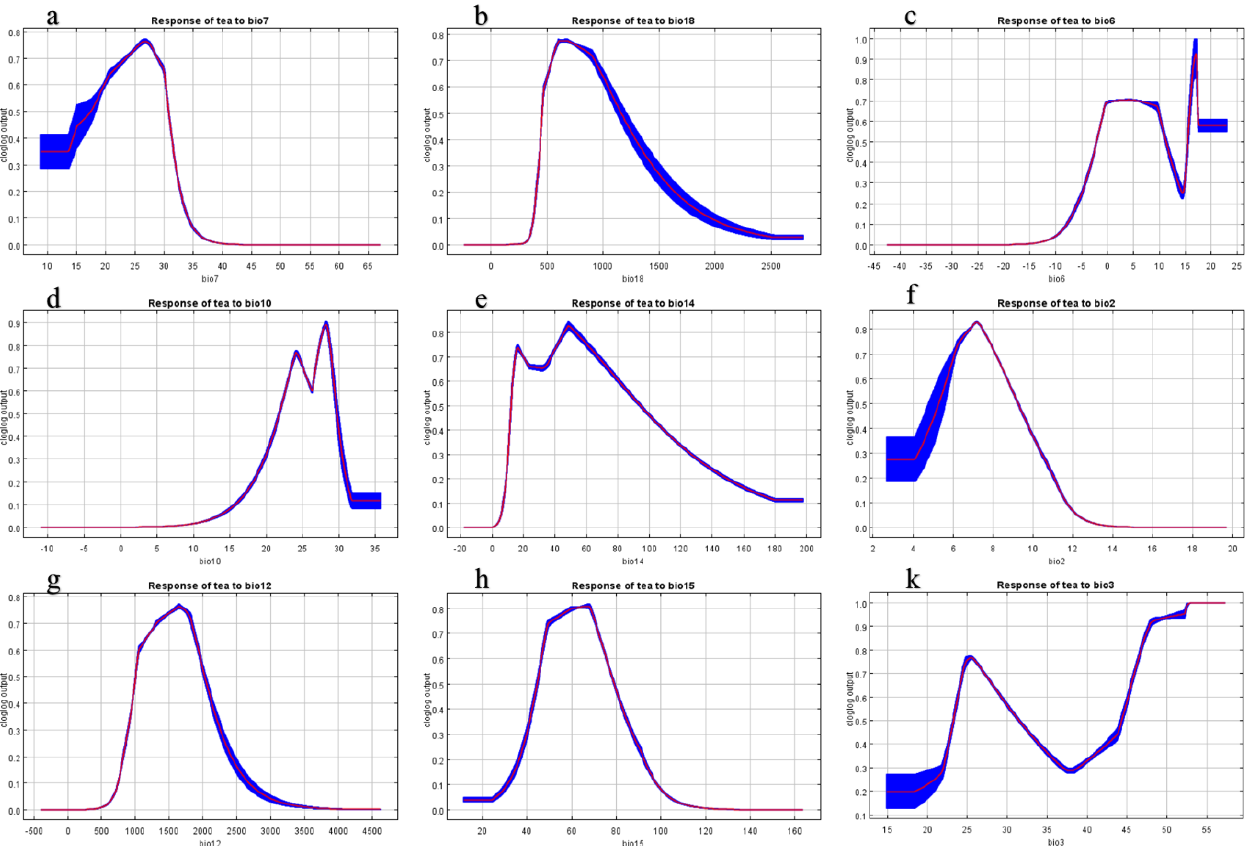
Figure 4. Response curves of climatic suitability for the major climate factors according to MaxEnt model. ( a ) response of tea to bio7 (Temperature Annual Range); ( b ) response of tea to bio18 (Precipitation of Warmest Quarter); ( c ) response of tea to bio6 (Min Temperature of Coldest Month); ( d ) response of tea to bio10 (Mean Temperature of Warmest Quarter); ( e ) response of tea to bio14 (Precipitation of Driest Month); ( f ) response of tea to bio2 (Mean Diurnal Range); ( g ) response of tea to bio12 (Annual Precipitation); ( h ) response of tea to bio15 (Precipitation Seasonality); ( k ) response of tea to bio3 (Isothermality).